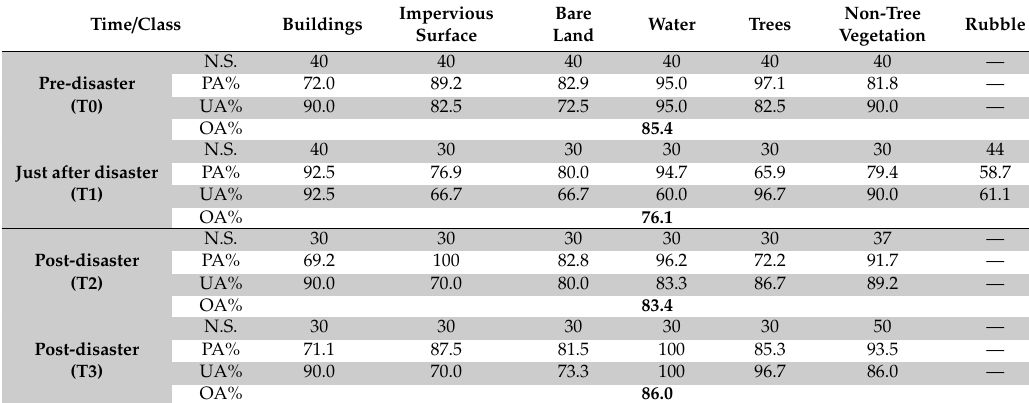
Table 4. The LC classification accuracies for T0, T1, T2, and T3 time epochs for Barangay 69. User’s and producer’s accuracies and corresponding errors are computed across the study area from the confusion matrices. PA—producer’s accuracy; UA—user’s accuracy; OA—overall accuracy; N.S—number of samples used for the accuracy assessment.